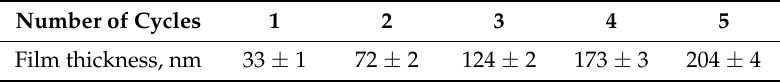
Table 1. Dependence of film thickness on the number of dip coating